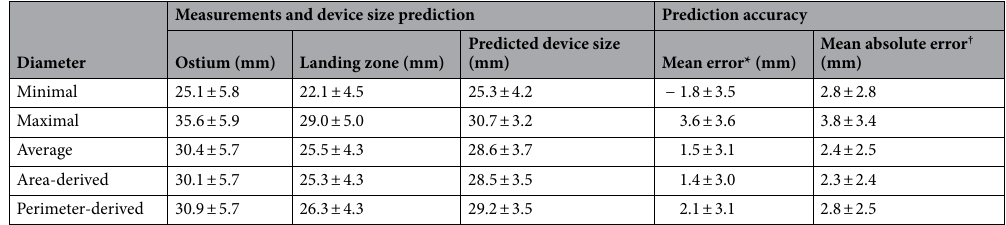
Table 4. Predicted device sizes using oversizing. Data are reported as means ± SDs. *The mean of the differences between the predicted device size and actual device size. † The mean of the absolute differences between the predicted device size and actual device